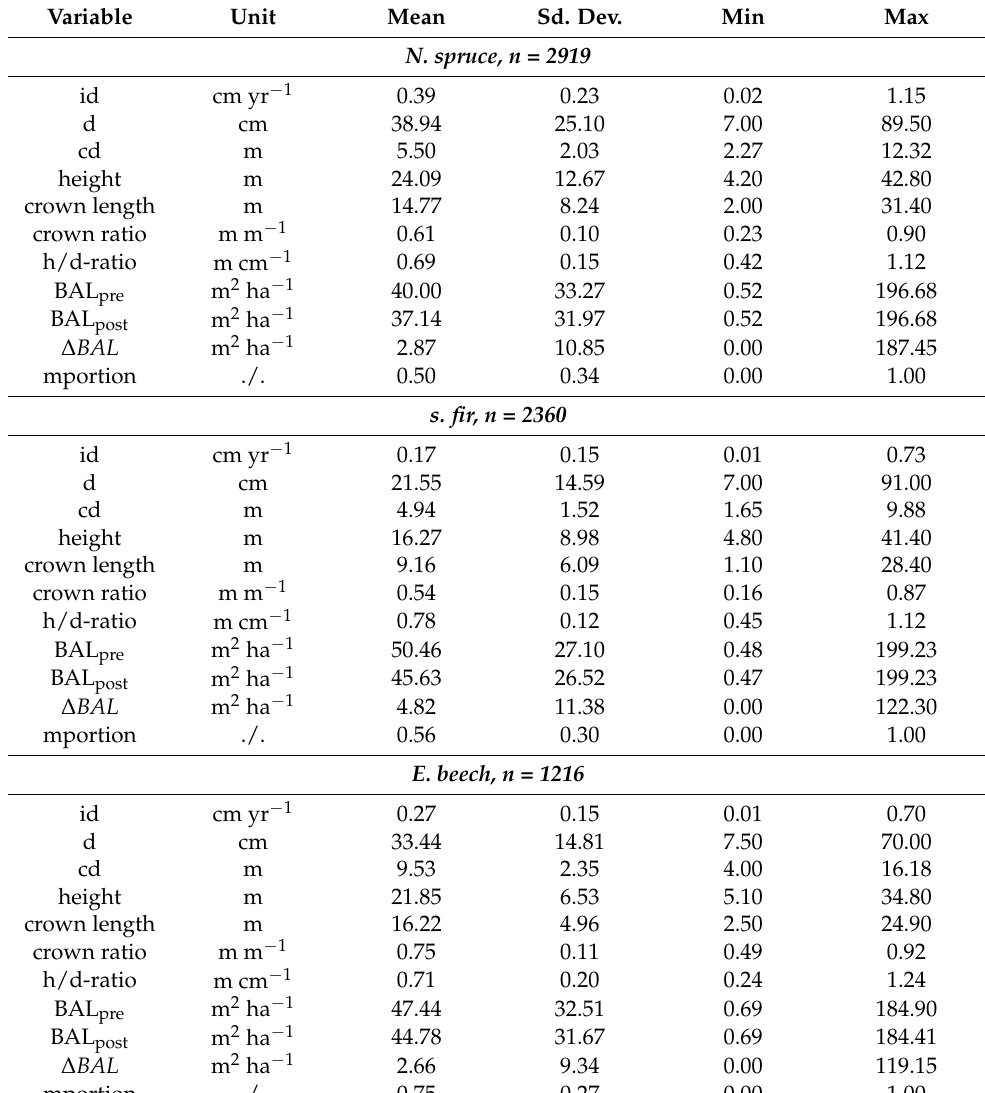
Table 3. Overview of the main data (comprising inventories from 1980 to 2018) for analyzing the dependency of the annual stem diameter growth, id, on stem diameter, d, crown diameter, cd, height, crown length, crown ratio, h/d-ratio, local stand density index, BAL, mixing proportion of the second species, mportion. Species-specific sample sizes, n, mean, standard deviation, minimum and maximum values for the three analyzed species combination are